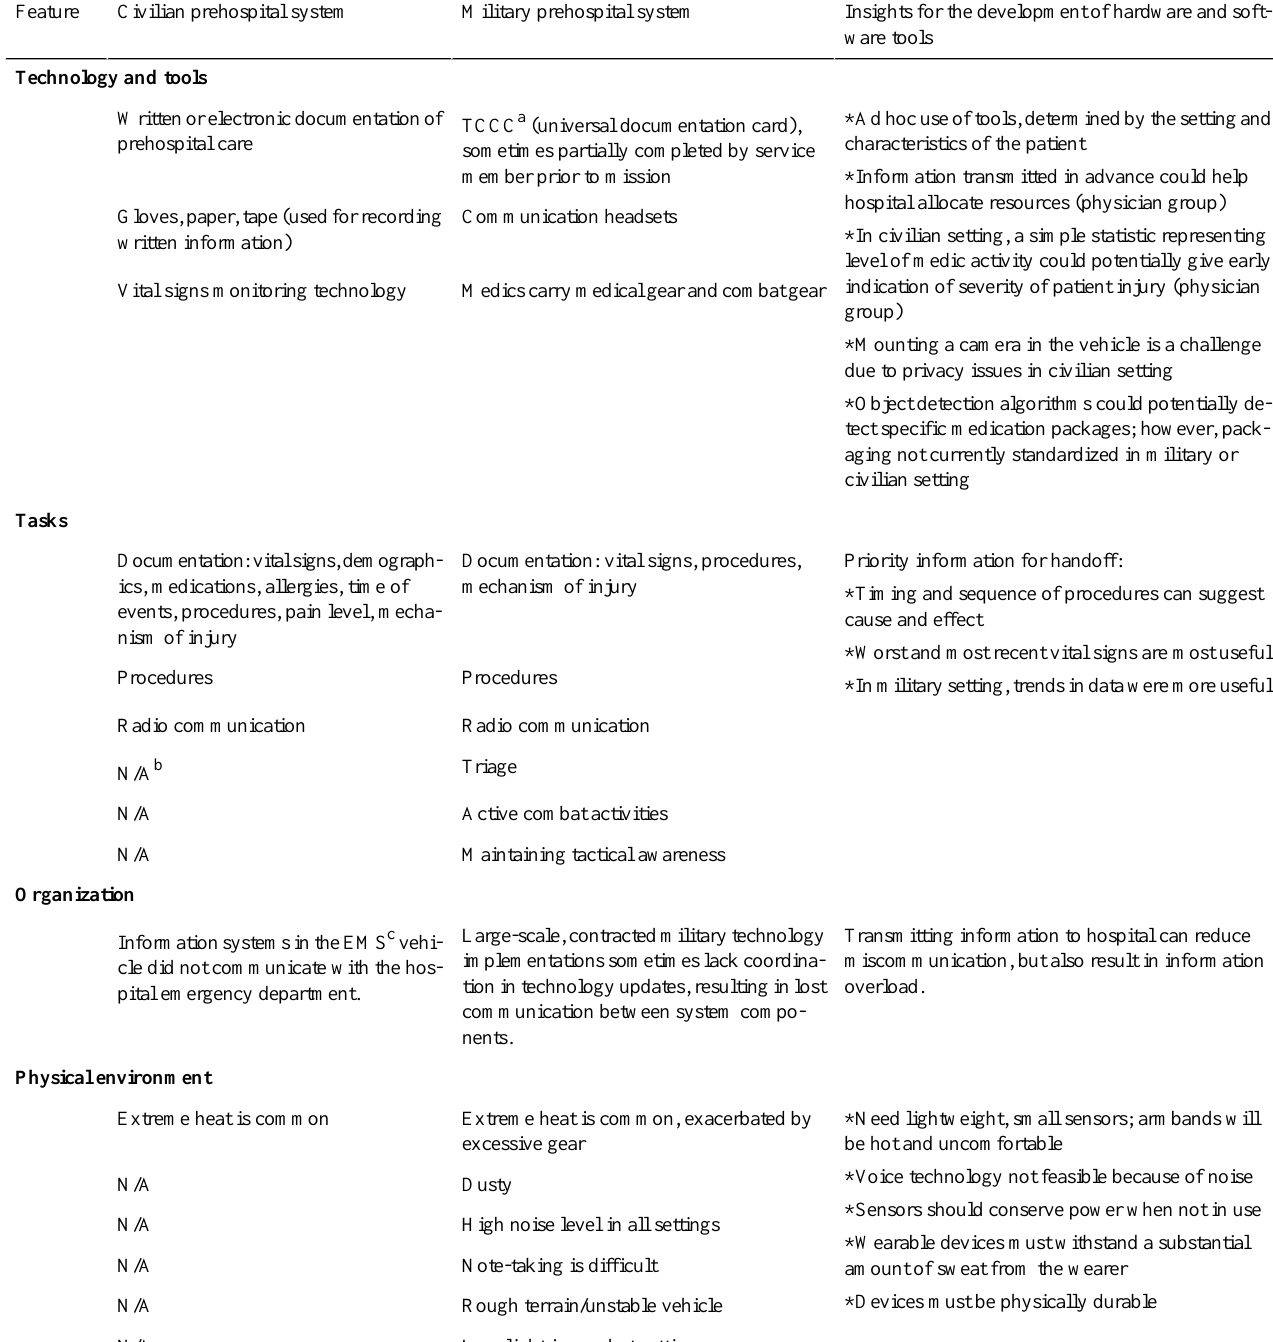
Insights for the development of hardware and soft-